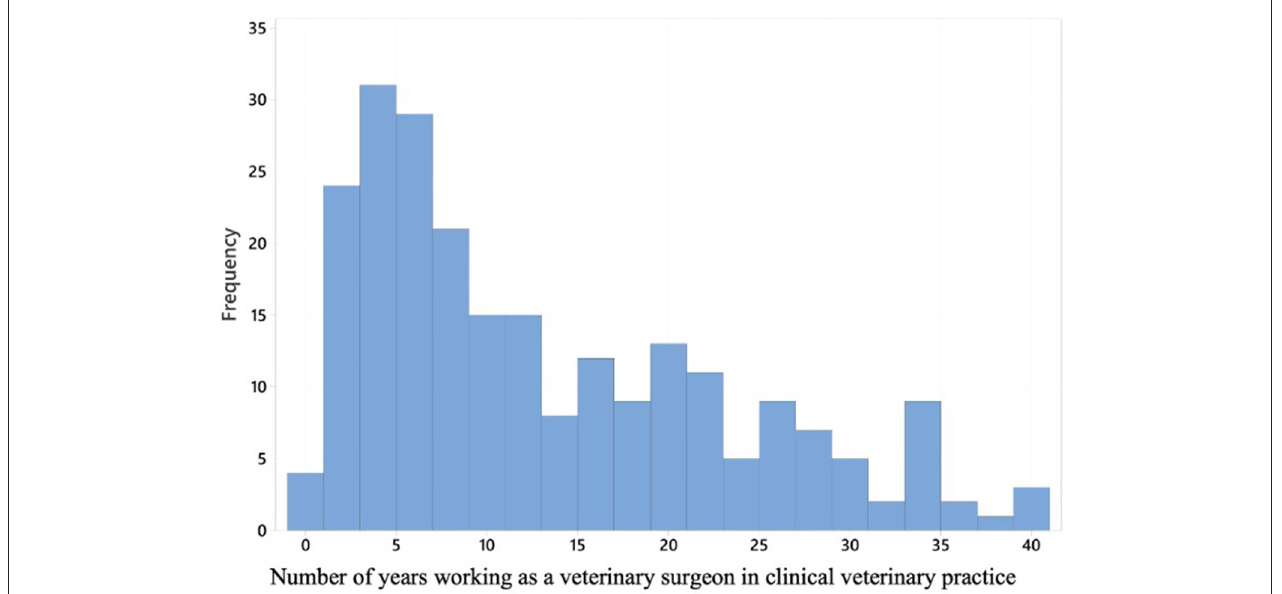
FIGURE 1 | A histogram displaying years’ experience working in clinical veterinary practice for the 235 respondents.